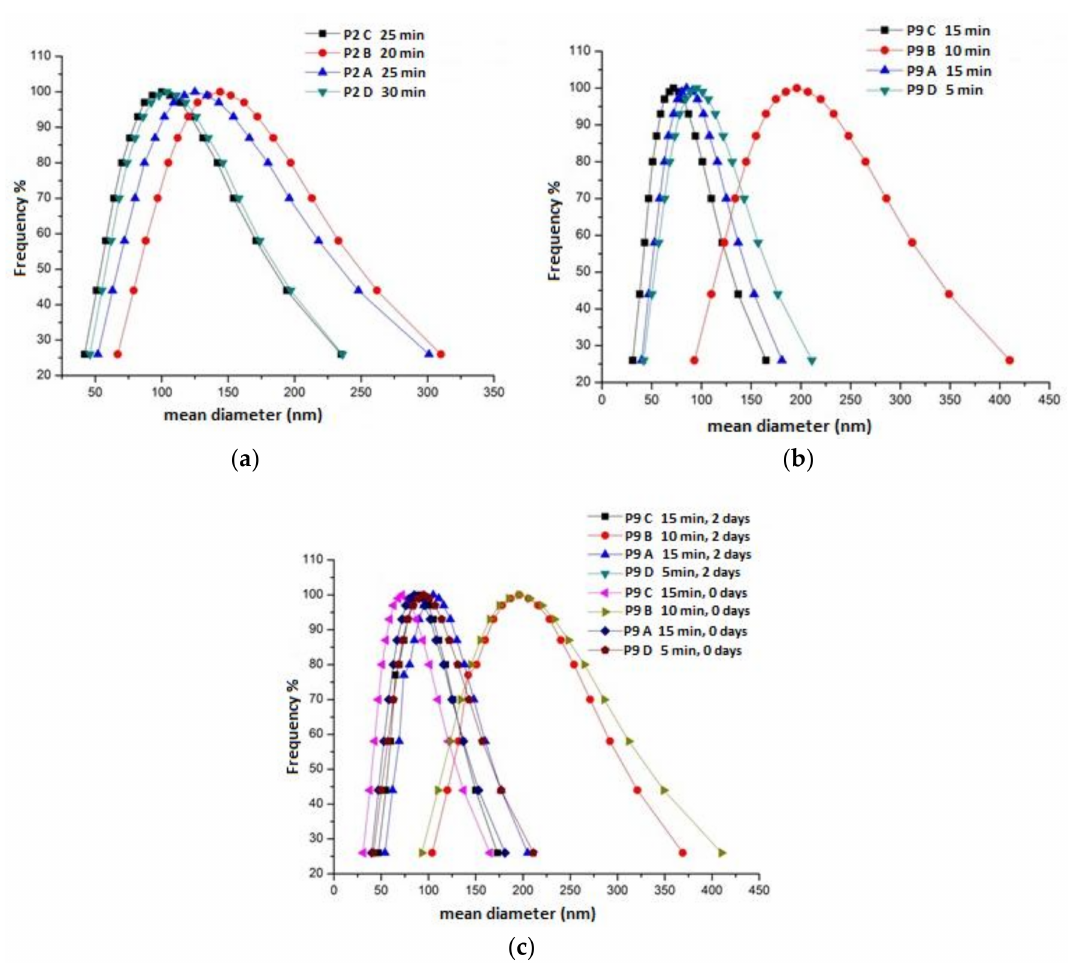
Figure 9. Particle size distribution curves of the optimized aqueous CCNP suspensions P2 and P9. Each curve shows the size distribution at the specified time elapsed after addition of the colloidal stabilizer: ( a ) sample P2; ( b ) sample P9; ( c ) sample P9 (two sets of measurements, right after and two days after sonication,